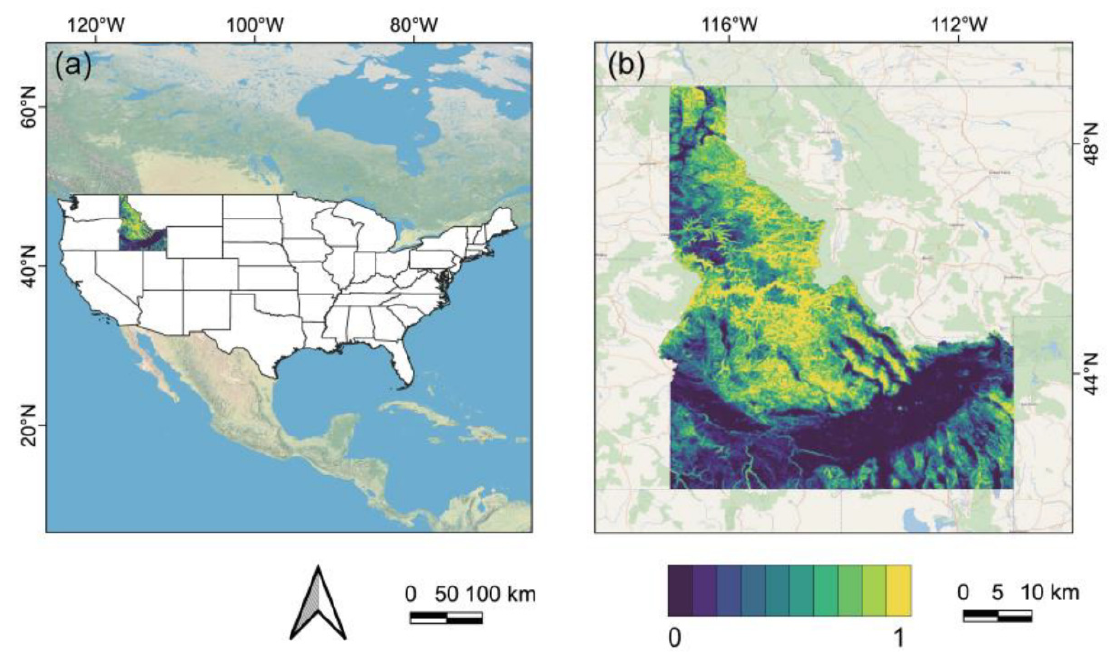
Figure 2. Schematic and geographical representation of the case study area: ( a ) base map of the contiguous United States with the location of the state of Idaho being indicated; ( b ) a topographic diversity map of the Idaho state from the Global SRTM Topographic Diversity dataset.